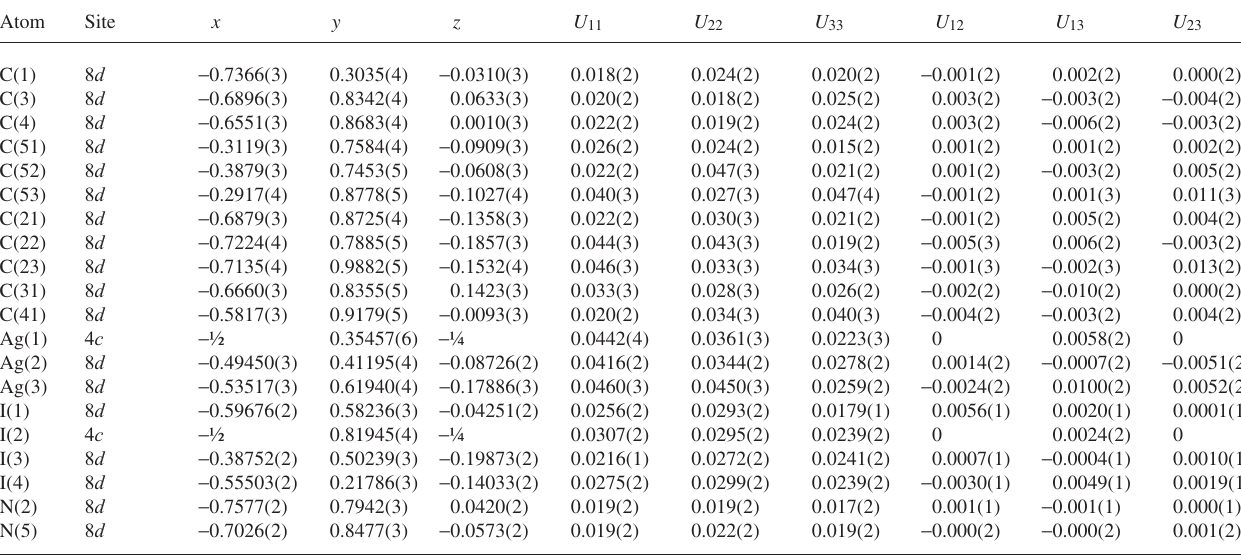
Table 3. Atomic coordinates and displacement parameters (in Å 2 ) .